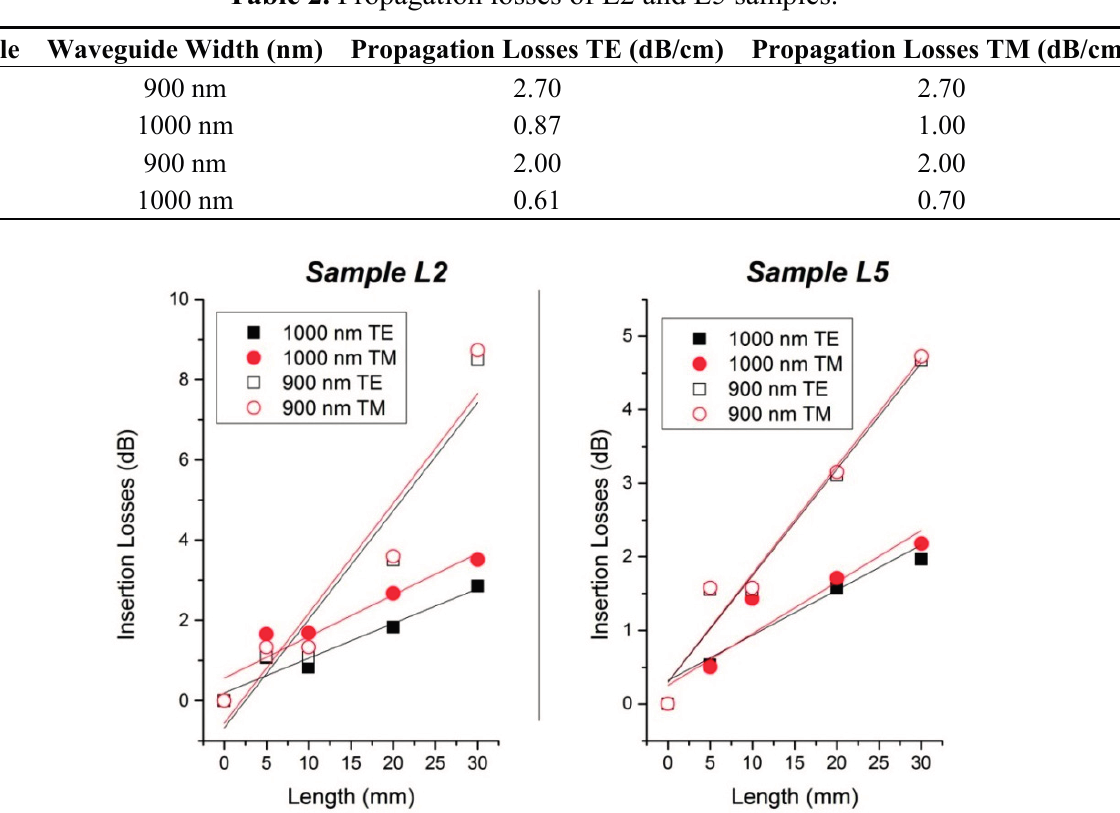
Figure 4. ( Left ) Propagation losses of sample L2; ( Right ) Propagation losses of sample